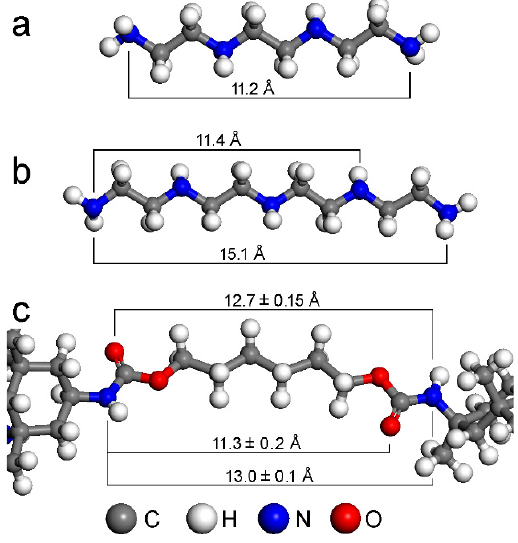
Figure 7. Functional groups’ distances in geometry optimized ( a ) TETA, ( b ) TEPA, and ( c ) PUR models used for the docking calculations. In the case of PUR, all segments in all PUR models were measured, and the average distance values, along with the standard deviations, were determined.